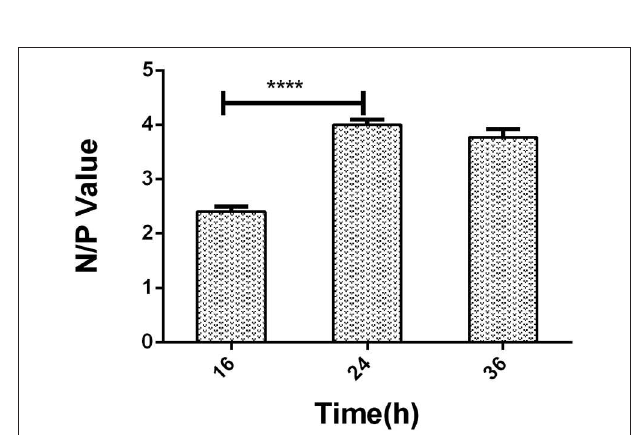
FIGURE 6 | The negative/positive OD value of different LPS coating time in O 9 Dc-ELISA. **** p < 0.0001.